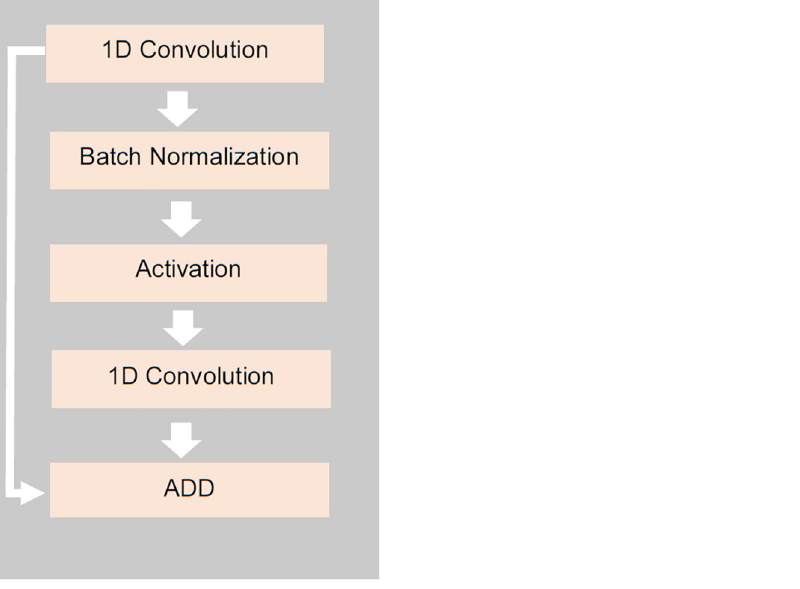
Fig 3. The architecture of a block of the feature extraction section of the proposed DeepHiFam. First, encoded sequence is fed into the 1st convolution unit. The extracted feature maps are batch normalized and input to the Relu activation, which helps to improve the speed, performance, and stability. The output of the 2nd convolutional unit is added to the output of the 1st convolution unit. 9 parallel blocks of different kernel sizes (see Table 3) are used for feature